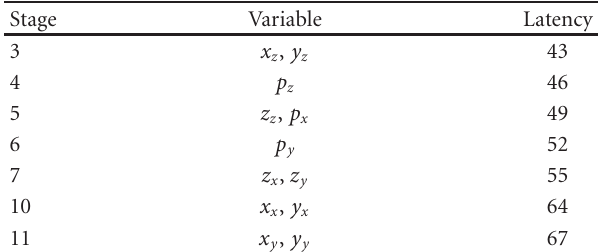
Table 7: Latency for each